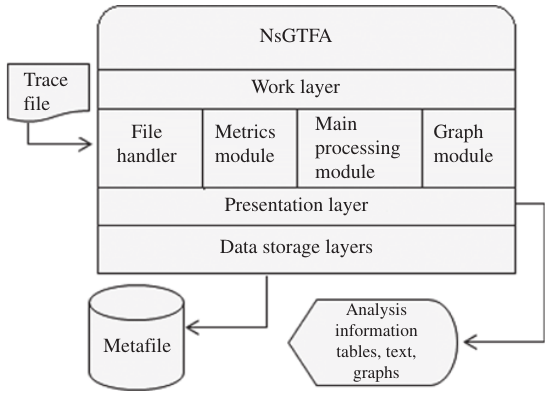
Figure 1. NsGTFA